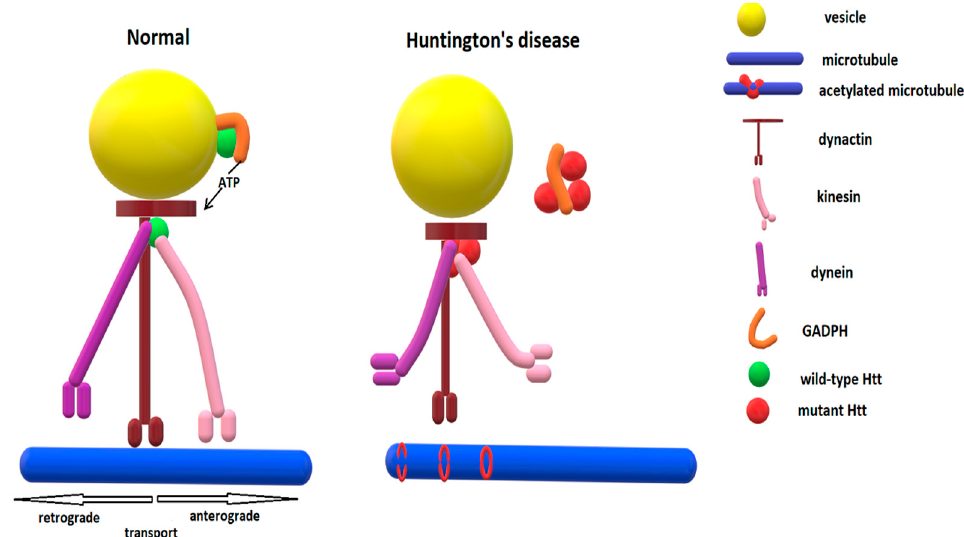
Figure 3. The involvement of Htt in normal vesicular transport and role of mHtt in impaired vesicular transport in HD. Under normal conditions, HTT interacts with the motor proteins dynactin, dynein, and kinesin and recruits GADPH to supply the necessary ATP. In HD, mHtt aggregates sequester GAPDH and motor proteins, and phosphorylates kinesin. Furthermore, microtubules are acetylated by mHtt, which hinders binding of kinesin-1 to the microtubules. Neurotrophin-3 is another trophic factor widely expressed in the nervous system, which acts by activation of the p75 receptor and of Trk C, B, and A receptors [268], and whose levels are reduced in HD [269]. It has been shown to reduce cellular damage, reg- ulate neuronal plasticity and synapse formation, and promote neuronal regeneration [270], effects which all make neurotrophin-3 an appealing therapeutic target. 5.6. Other Disturbances in Signaling HD progression is accompanied by alterations in neurotransmitter levels and their receptor density in the basal ganglia and midbrain [271], as well as by dysfunction of the neuronal circuit connectivity [121]. Most of the striatal neurons (90–95%) are GABAergic medium spiny neurons (MSNs) receiving mainly glutamatergic cortical and thalamic projections, and projecting to the globus pallidus (GP) pars interna, pars externa, substantia nigra, and thalamus. The re- maining 5–10% of neurons are GABAergic and cholinergic interneurons [272]. The MSNs are of two main subtypes: MSNs rich in substance P and dynorphin, enriched in dopa- minergic D1 receptors, which project to the GP pars interna and the thalamus, and which are considered to constitute the direct pathway, and MSNs rich in enkephalin, who also express dopaminergic D2 receptors and adenosine A2A receptors, which project to the GP pars externa and belong to the striatal indirect pathway [121]. Any imbalance in the activ- ity of these two pathways results in alterations of movements, as are seen in HD or Par- kinson’s disease. However, there are other differences between MSNs in the direct and indirect pathways as well, aside from the dopaminergic receptors they express. In vitro studies have shown differences in resting membrane potential, excitability, threshold for action potential generation [273], and morphologic differences relating to the dendritic surface area [274]. A differential pattern of MSN loss has been described. Early in HD, increased gluta- mate input appears onto MSNs in the direct pathway, likely occurring presynaptically [23] and due to the blocking of endocannabinoid release by MSNs, which eliminates the negative control normally exerted by endocannabinoids on neighboring terminals [275].